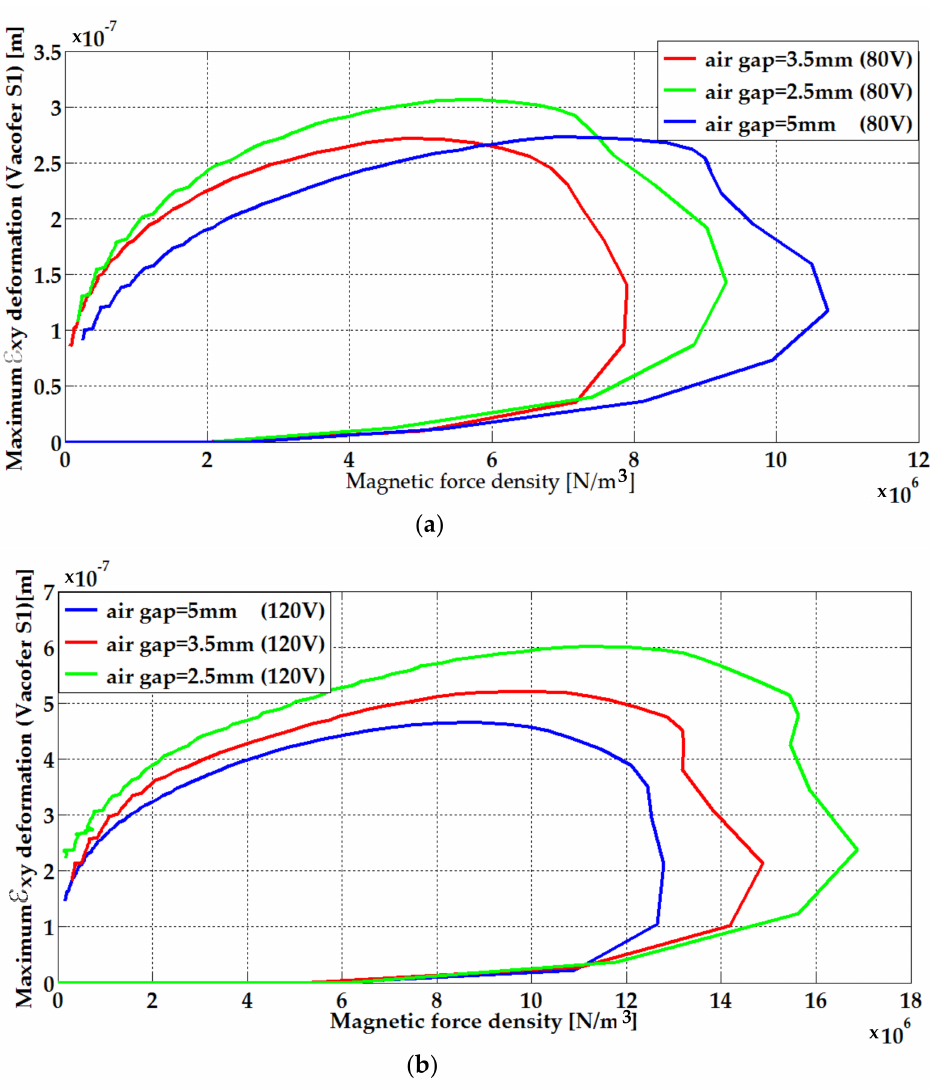
Figure 13. Maximum deformation according to the supplied voltage and the air-gap thickness of the Vacofer S1 magnetic non-linear and conductive material: step voltage of ( a ) 80 V, and ( b ) 120